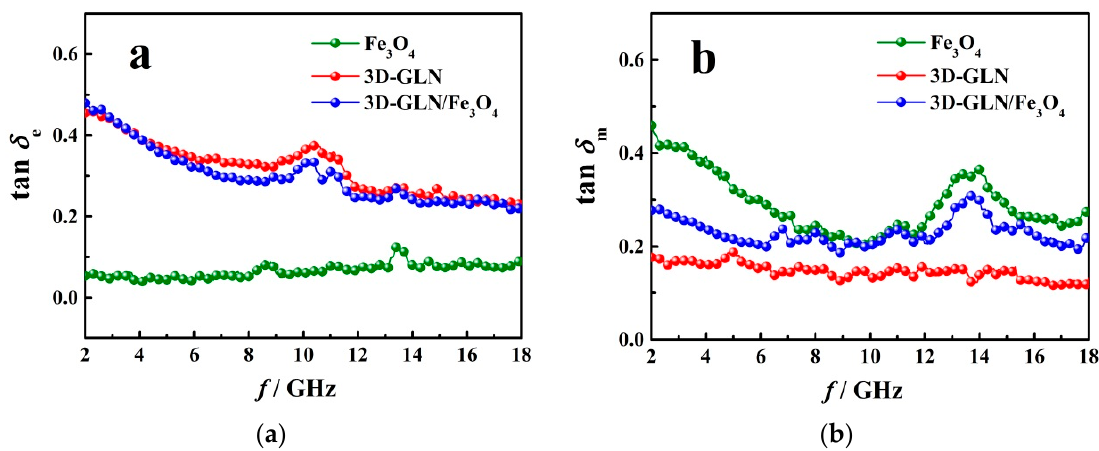
Figure 9. Frequency dependence of tan δ e ( a ) and tan δ m ( b ) of Fe 3 O 4 , 3D-GLN and 3D-GLN/Fe 3 O 4 .